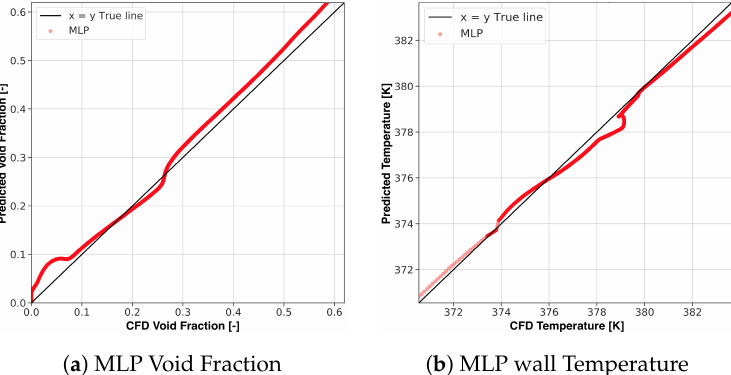
Figure A3. Regression chart of CFD vs DNN/MLP predicted void fraction and wall temperature for an extrapolation dataset at q (cid:48)(cid:48) = 40,000 W/m 2 , u = 0.2 ms − 1 . From both the plot it is evident that the MLP model lacks in reproducing the physics on an extrapolated